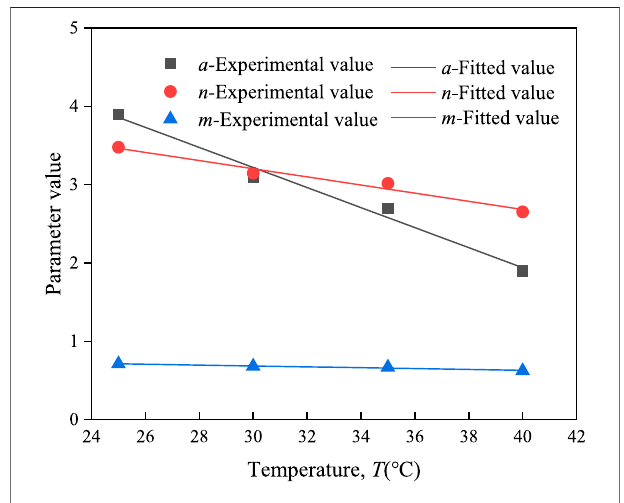
FIGURE 4 | Changes in VG model parameters of unsaturated soil at different